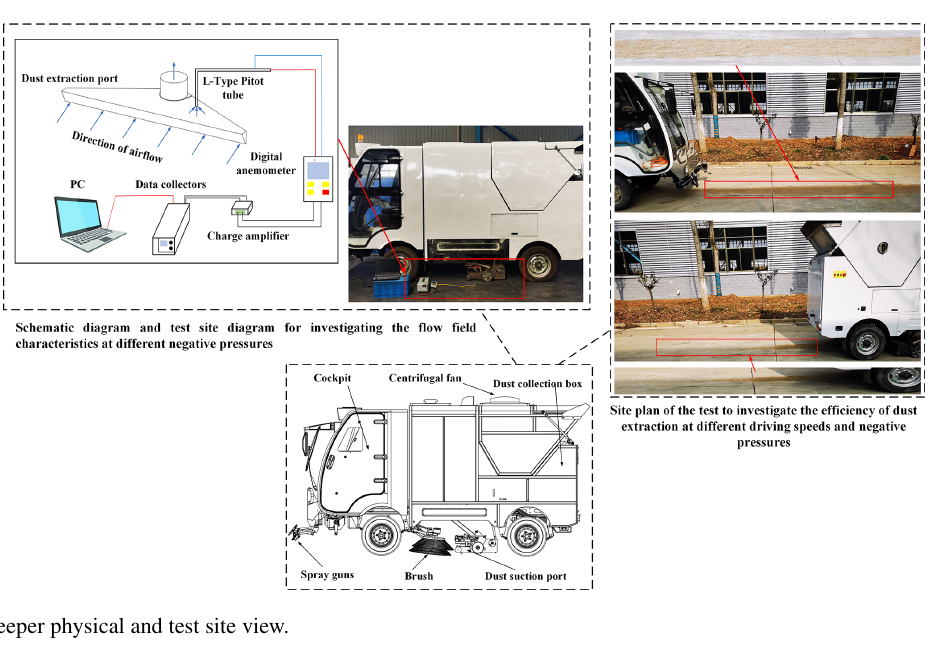
Figure 8. S26 sweeper physical and test site view.